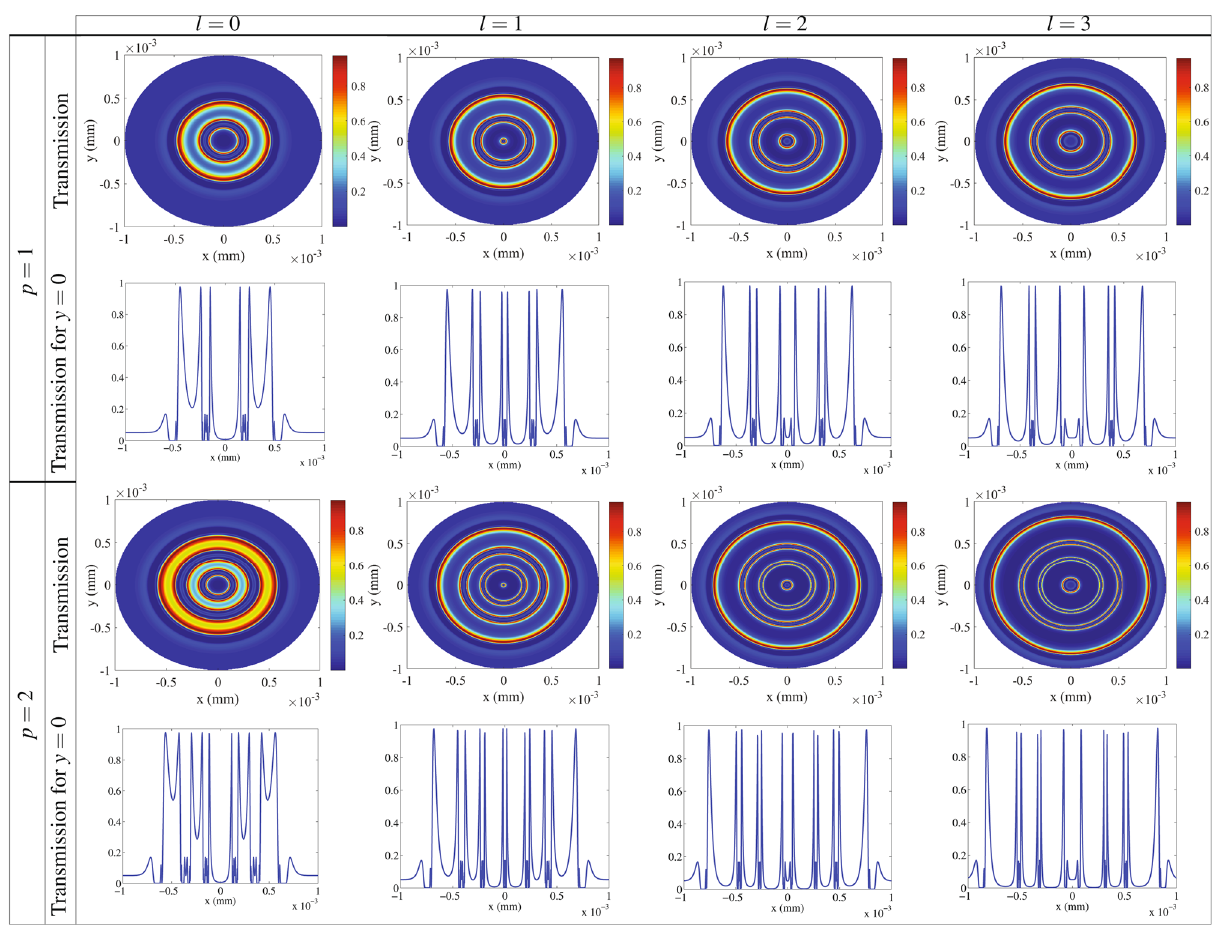
Figure 7. The y -polarized intensity distribution of the VB as a function of x and y for different OAMs of the 1 (first row) and p 2 ( third row) of the LG control field. The corresponding perspective of radial indices p = = 0 for p 1 (second row) and p 2 (fourth the transmission of the generated VBs in y = = =